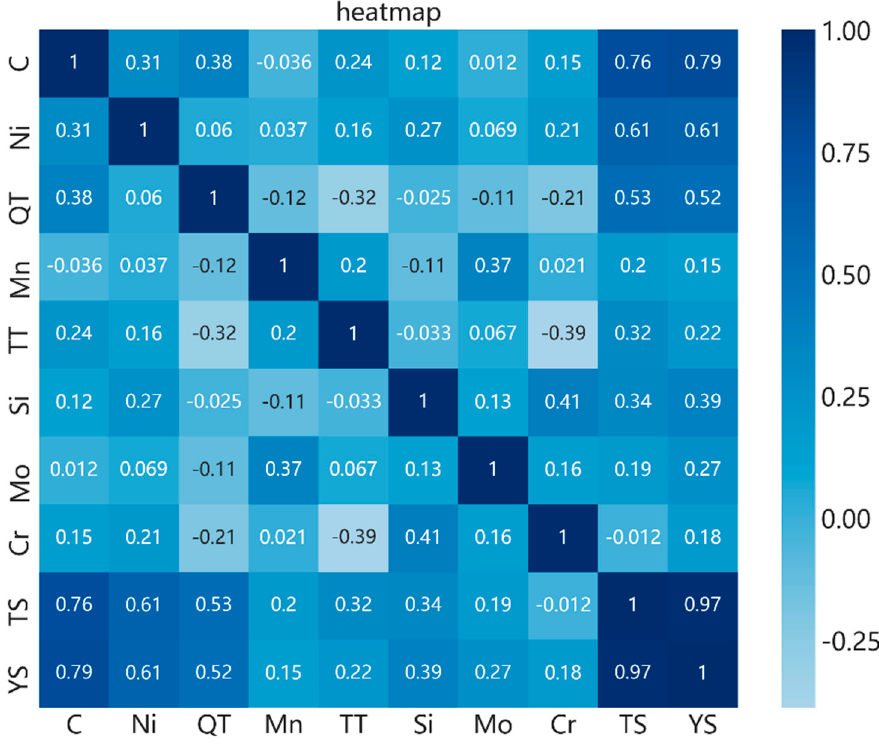
Figure 7. Thermal diagram of alloying elements related to tensile strength.